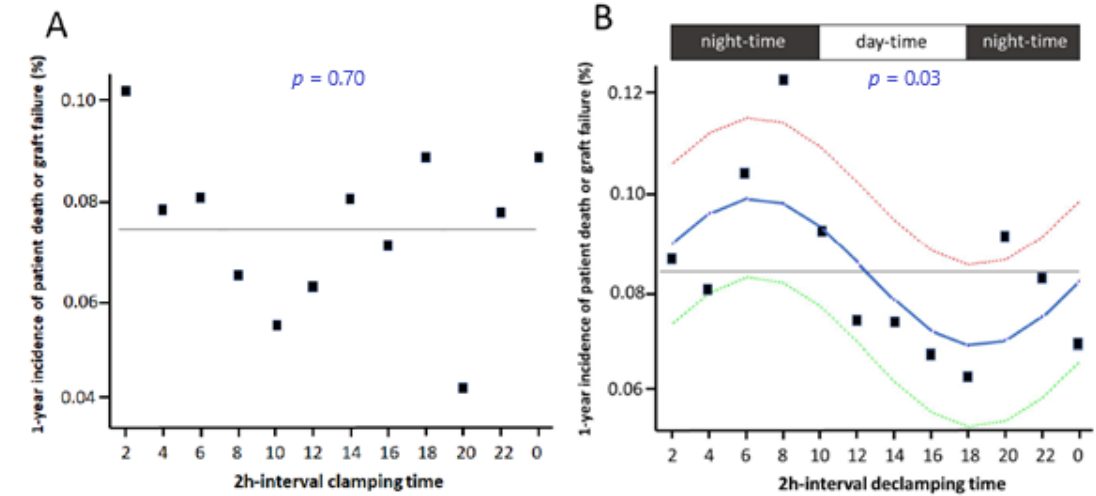
Figure 2. Non-adjusted 1-year survival according to clamping ( A ) and declamping ( B ) time-of-the-day. Patients were grouped by 2-h intervals according to clamping ( A ) or declamping ( B ) time-of-the-day. Square symbols: Incidence, p -value, and solid line by cosine function with period of 24 h by sinusoidal regression model, dashed lines: 95% confidence interval.